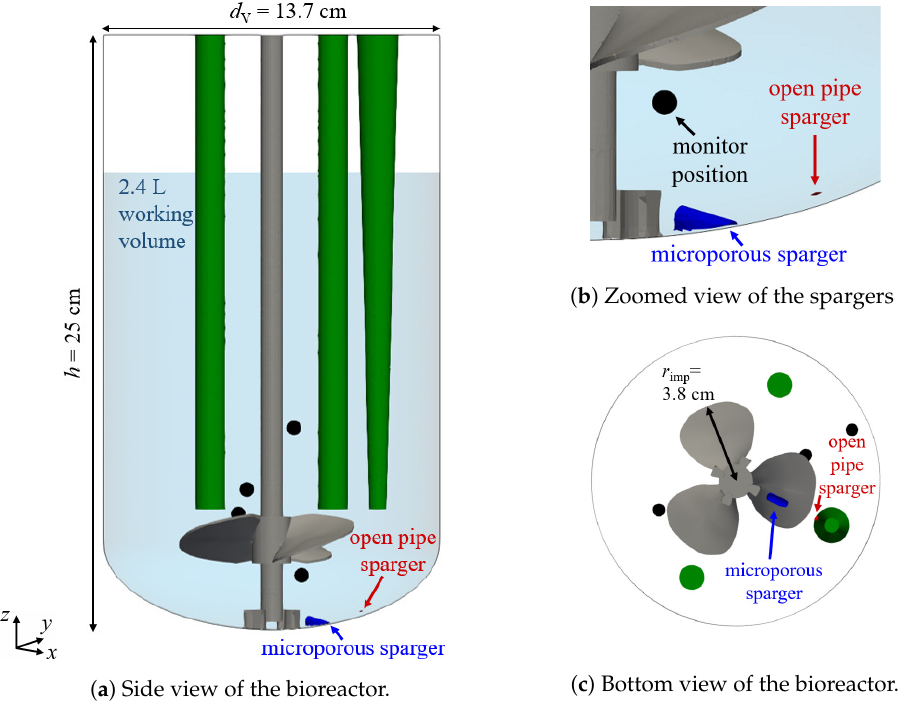
( c ) Bottom view of the bioreactor. Figure 1. Configuration of the Mobius ® CellReady 3 L. The sensors, the microporous sparger, and the open pipe sparger are shown in green, blue, and red color, respectively. The four monitor positions for the mixing time are marked with black